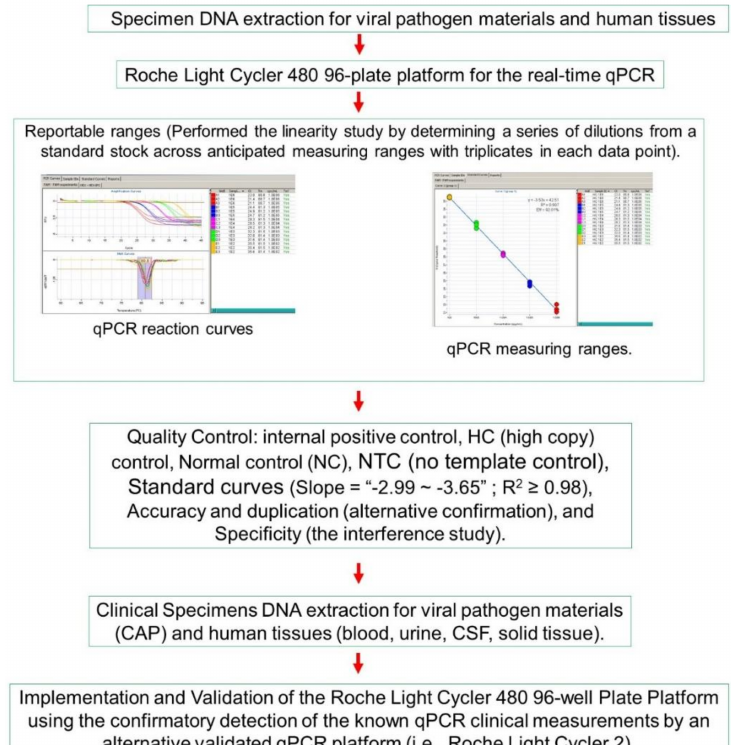
Figure 1. Overall schematic diagram representing the